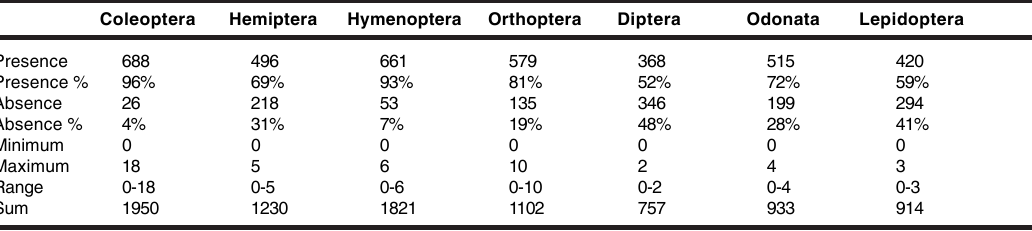
Table 4. Comparative statistics for different prey items found in the Small Bee-eater pellets (n=714)